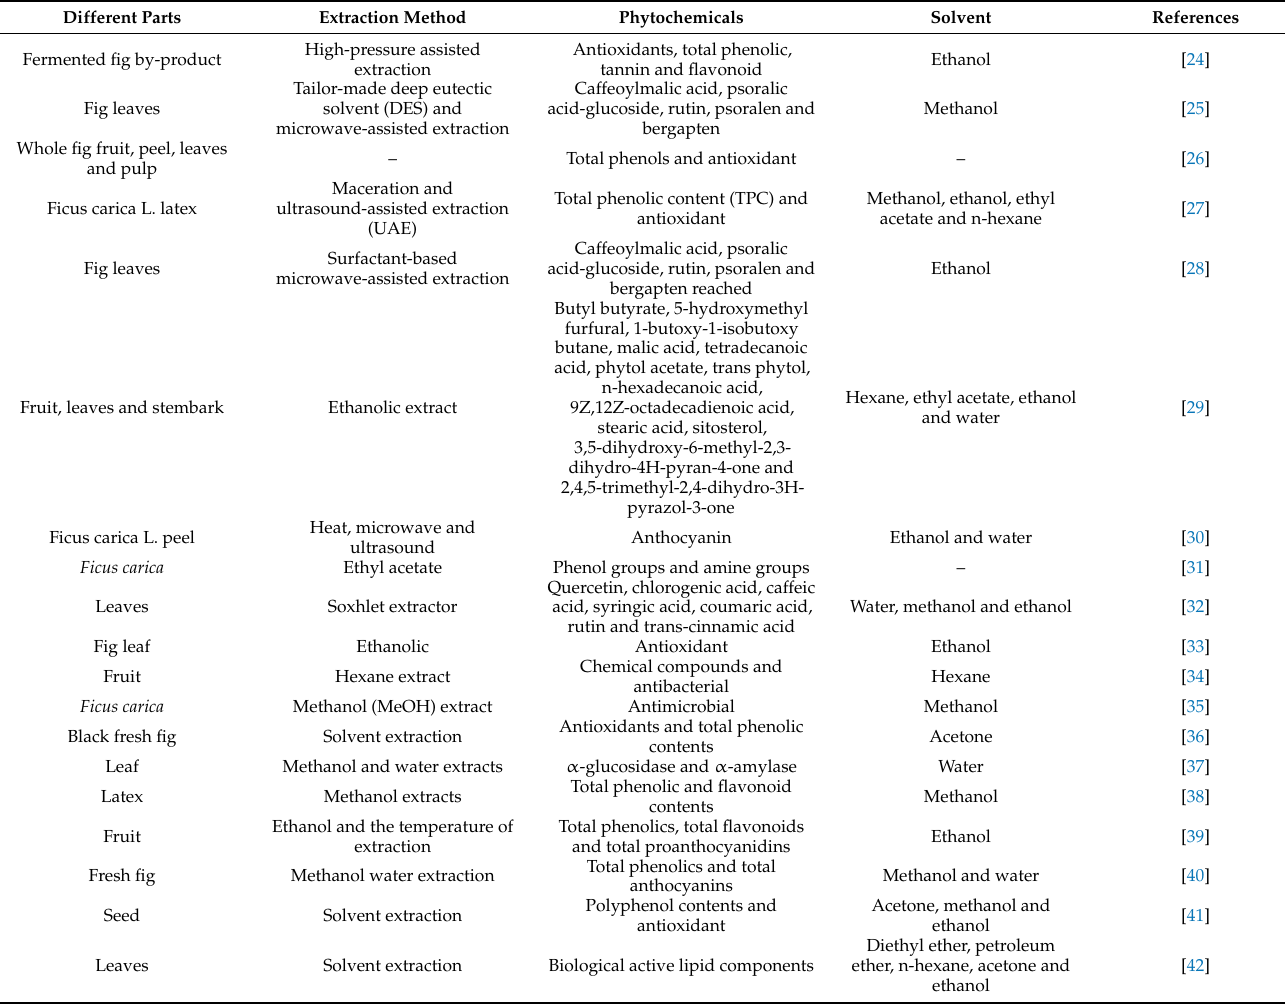
Fig leaf Ethanolic Antioxidant Fruit Hexane extract Chemical compounds and antibacterial Methanol (MeOH) Ficus carica Antimicrobial extract Black fresh fig Solvent extraction Antioxidants and total phenolic contents